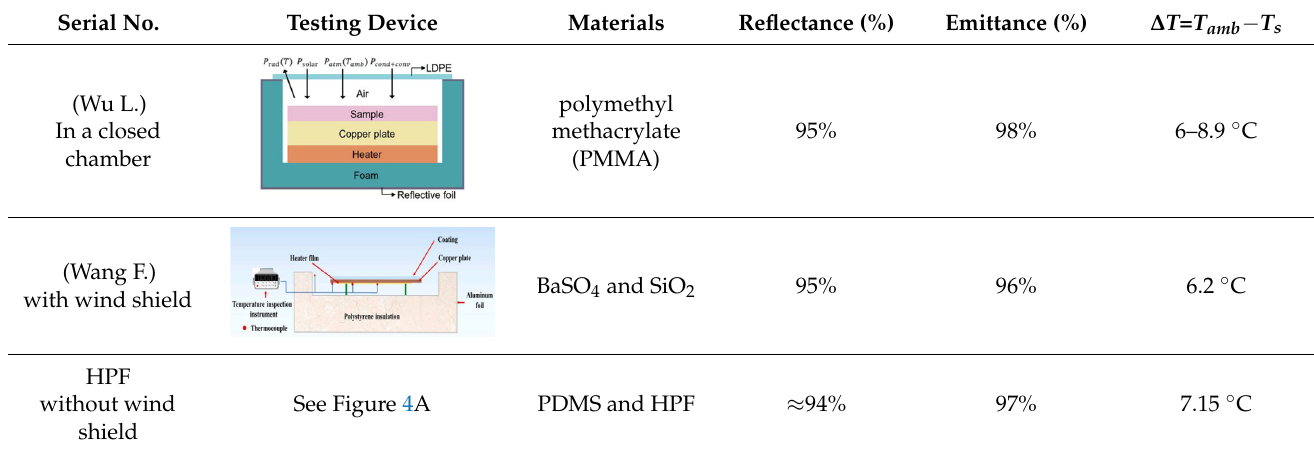
Table 1. Comparison between different testing devices [42,51].